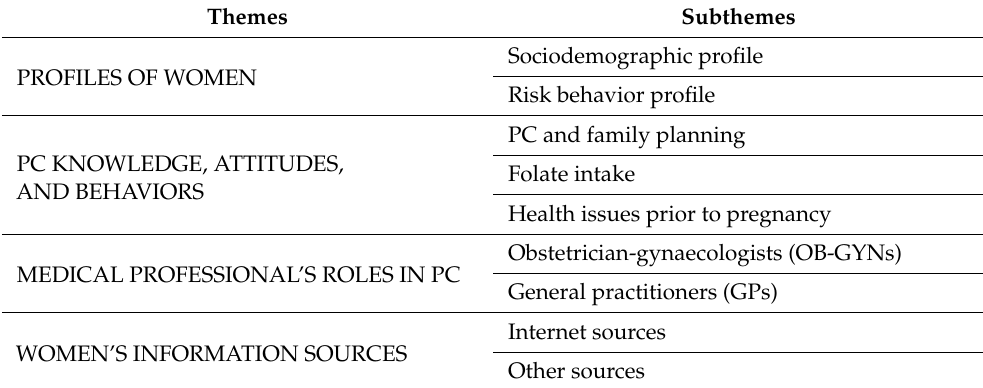
Table 2. Summary of the main themes and